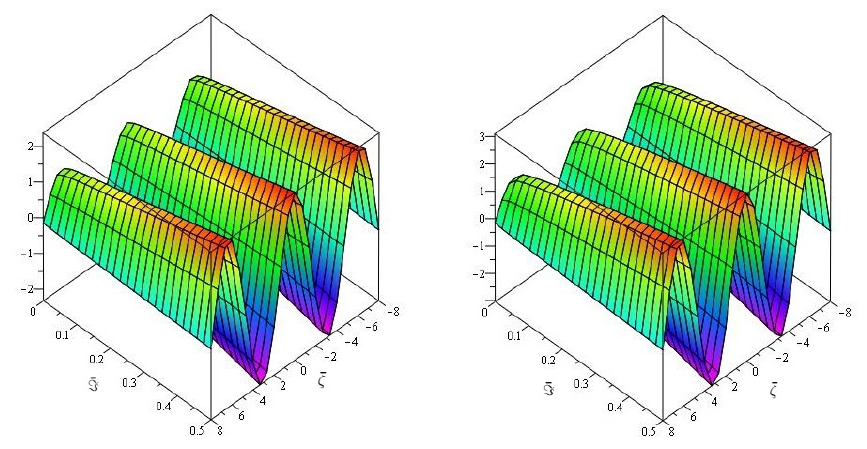
Figure 8. The first graph of analytical solution of β = 0.6 and second is β = 0.4 for Example 3.